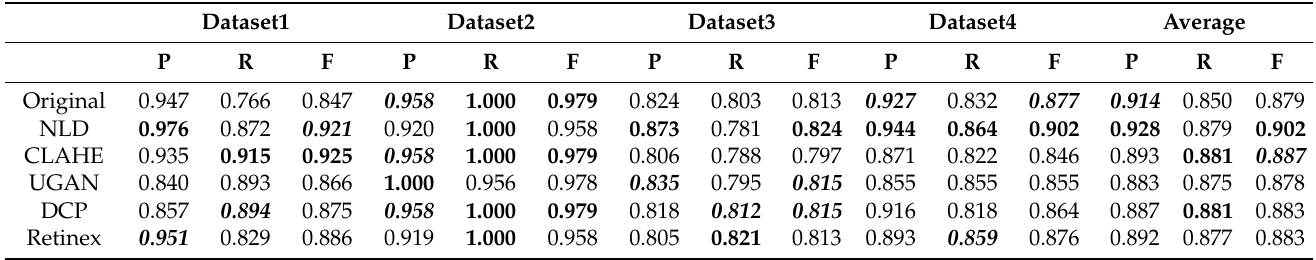
Table 5. Precision–recall analysis of YOLOv7 with image enhancement (Bold font indicates the best result and italic indicates the second-best result).